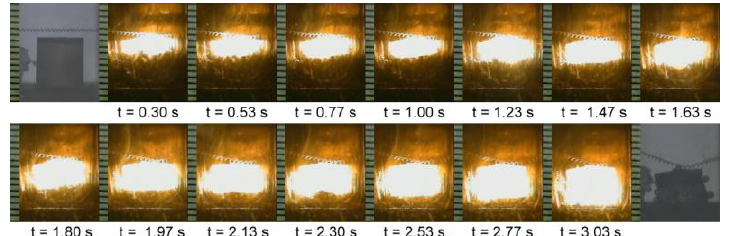
Figure 2. A time series of recorded images illustrating self-propagating combustion wave of Reaction (1) with x = 1.5 (unit of scale bar: 1 mm).